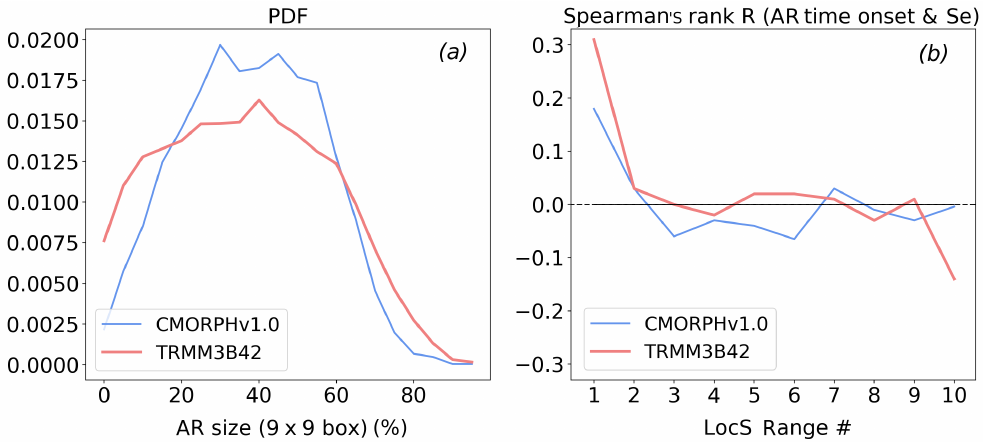
Figure A2. ( a ) Probability histogram of AR system size estimated for the TRMM-3B42 and CMORPH-v1.0 datasets. The AR size parameter here is calculated as a percentage of AR pixels within an event box of 9 × 9 pixels; the 9 × 9 deg box is commensurate with the 90th percentile of all possible meso-scale convective system size values, i.e., 200,000 km 2 [72], and therefore should be well suited for capturing the range of possible AR areas. ( b ) Spearman’s rank correlation between the soil moisture gradient and the onset time of afternoon rainfall calculated for each of the ten LocS ranges for either the TRMM-3B42 (red) or CMORPH-v1.0 (blue) dataset. Correlation is first estimated in every 5 × 5 degree grid box as in Figure 4 and then averaged across the domain.